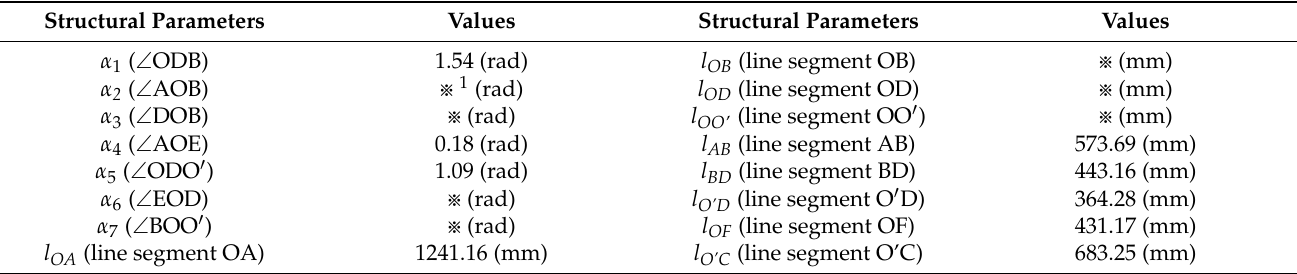
Figure 7. Single wishbone suspension structure of 1/6 vehicle: ( a ) 3D drawing; ( b ) 2D structure diagram. Table 1. Single wishbone suspension structural parameters of 1/6